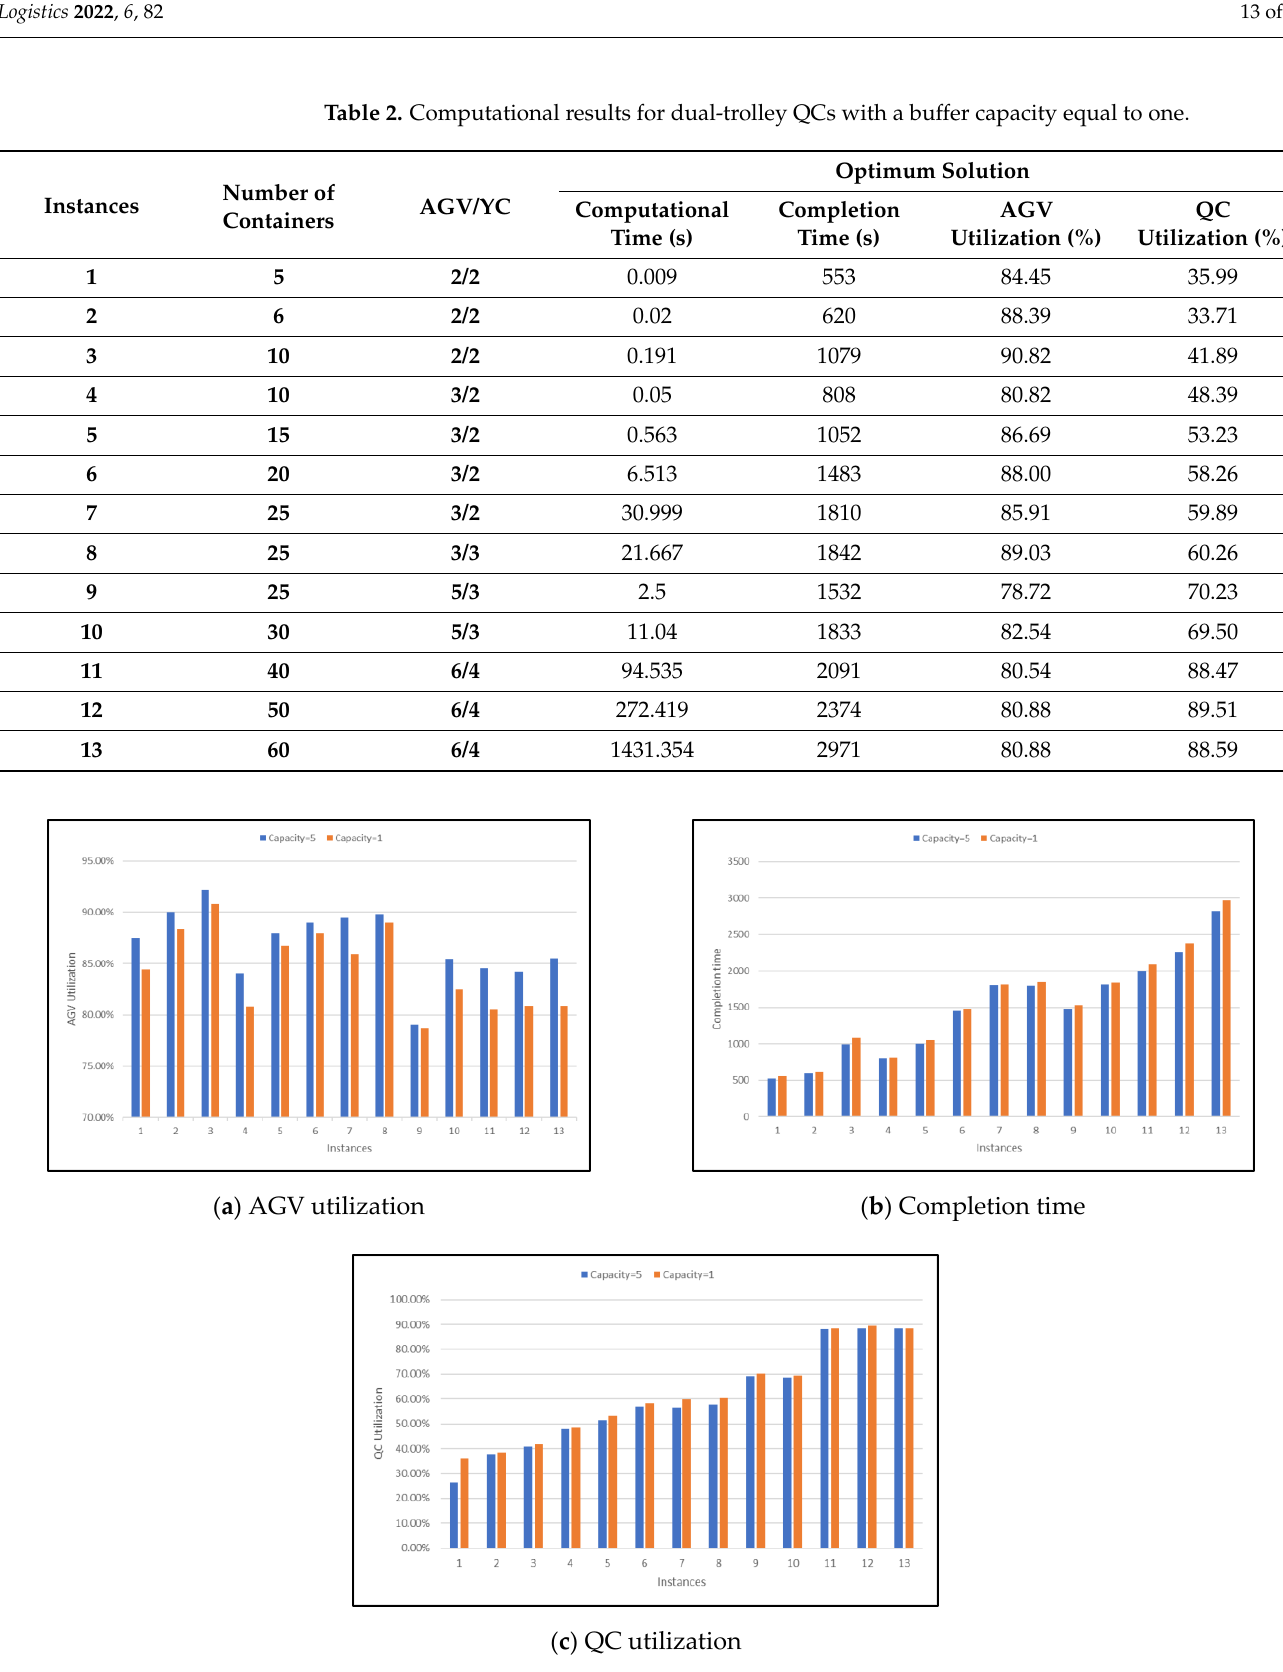
Figure 5. Comparison of using the QCs buffer capacity equal to five or one ( a – c ) .